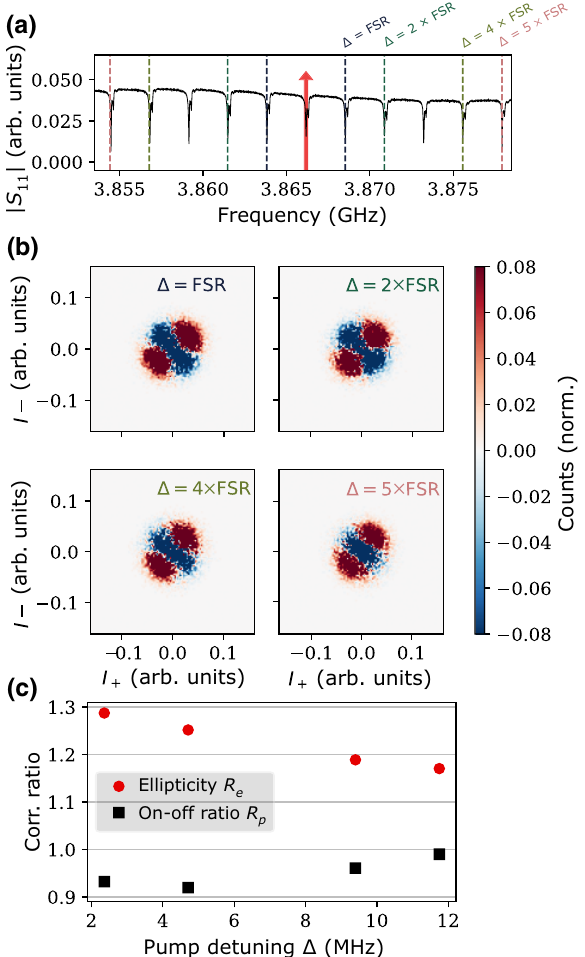
FIG. 3. Two-mode squeezing. (a) Measurement configuration where the red arrow indicates the pump frequency. Dashed lines indicate probe frequencies for collecting quadrature noise data. (b) Histograms of two-mode correlation data where the mea- surement with the pump turned off is subtracted. The label I + ( I − ) denotes the I quadrature of modes at frequencies above (below) the pump frequency. The label (cid:4) indicates the detuning of the modes from the pump. The histograms for all two-mode quadrature combinations for the (cid:4) = FSR case are shown in Appendix G. (c) Squeezing ellipticity and ratio of standard devi- ations of the noise in the squeezed quadrature relative to the pump-off case. The quantities are plotted as a function of detun- ing of the measured mode pair from the pump. All modes show squeezing below the pump-off level, and the error bars are smaller than the plot